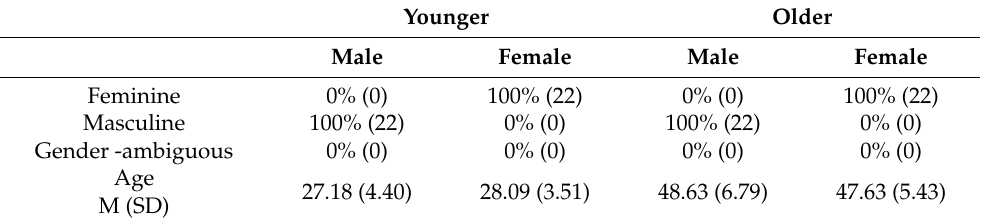
Figure 1. AI voice actor service “Typecast”. Table 1 . Four types of voices.